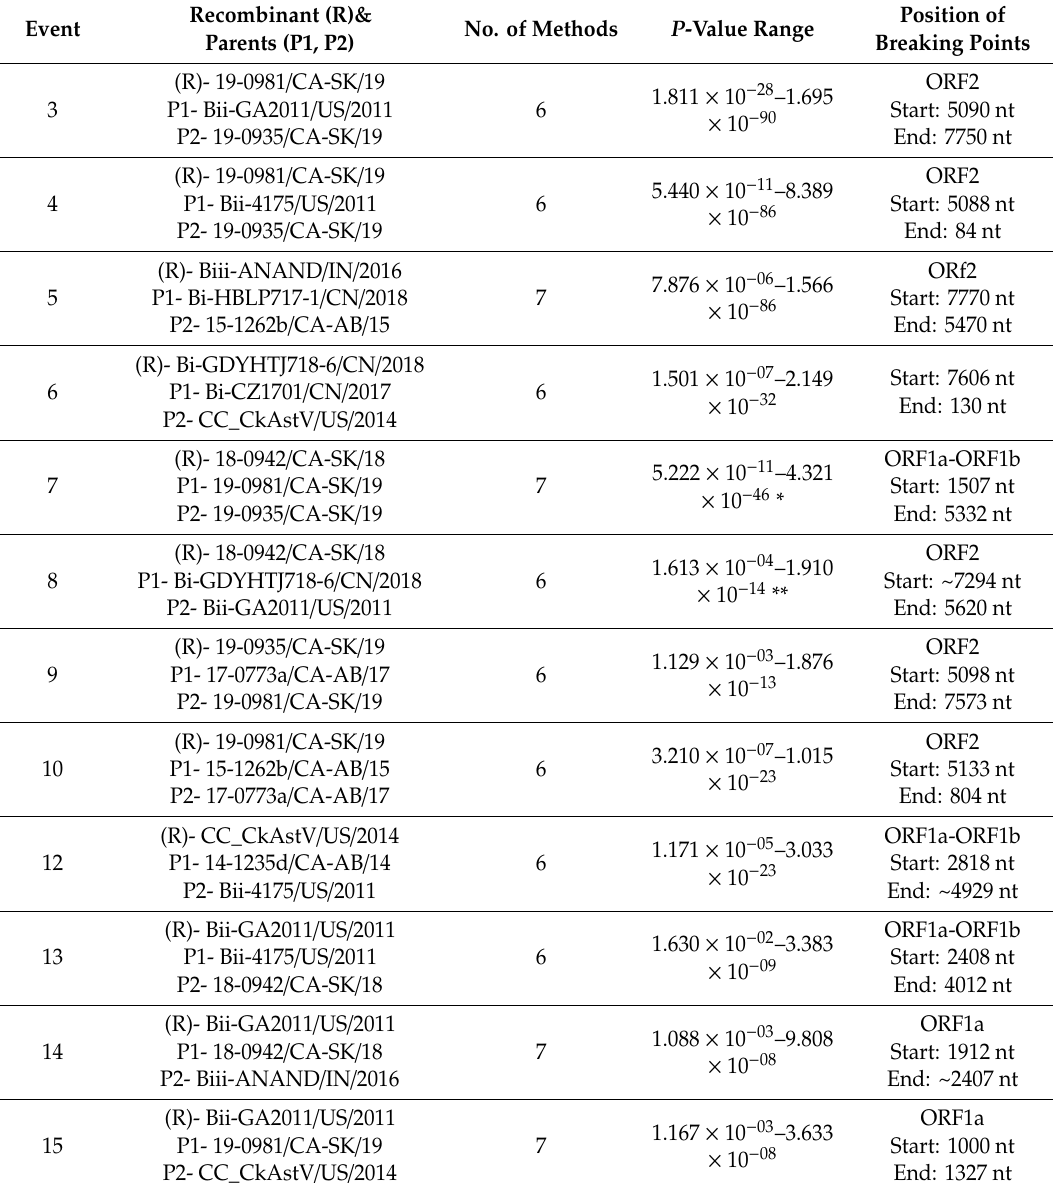
Table 3. Details on Recombination Events detected by at least 6 methods on alignment of 24-CAstV complete